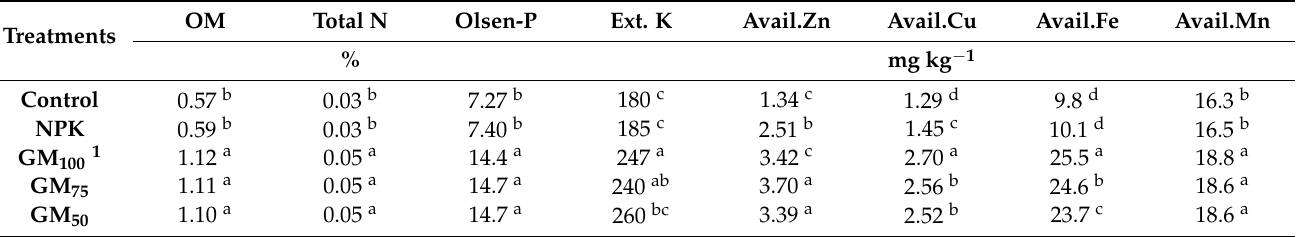
Table 3. Effect of green manuring and NPK fertilizer on physicochemical properties of soil (average of three years) from 2015 to